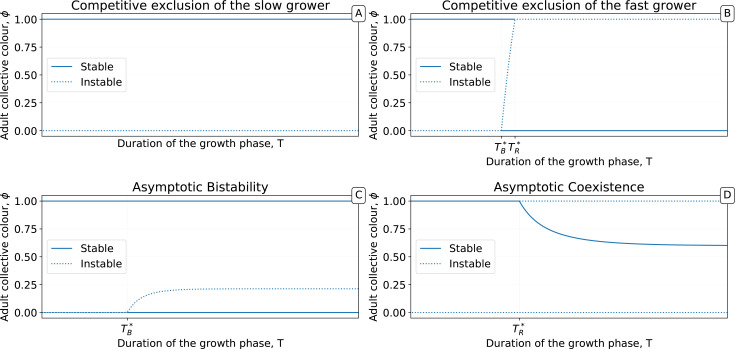
Bifurcation diagrams showing the position and stability of the fixed points of Gθ as a function of the duration of the collective generation T.(A-D) Particle traits are representative of the scenarios illustrated in Figure 7A–D. Of particular interest is the case illustrated in panel D, where the Gθ function acquires — for a sufficiently large separation between the particle maximum division time and the collective generation time — a stable internal fixed point.